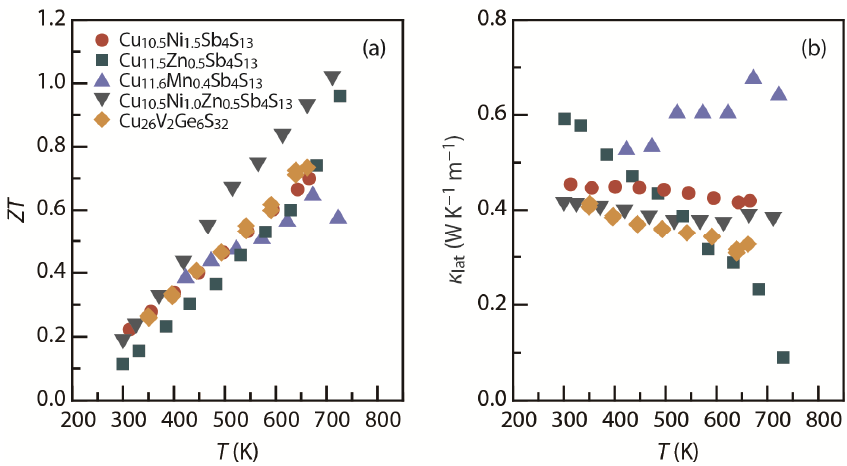
Figure 13. Temperature dependence of ( a ) thermoelectric figure of merit ( ZT ) ( p -type); and ( b ) lattice thermal conductivity ( κ lat ) for the tetrahedrites Cu 10.5 Ni 1.5 Sb 4 S 13 [36], Cu 11.5 Zn 0.5 Sb 4 S 13 [124], Cu 11.6 Mn 0.4 Sb 4 S 13 [125], and Cu 10.5 Ni 1.0 Zn 0.5 Sb 4 S 13 [37] and